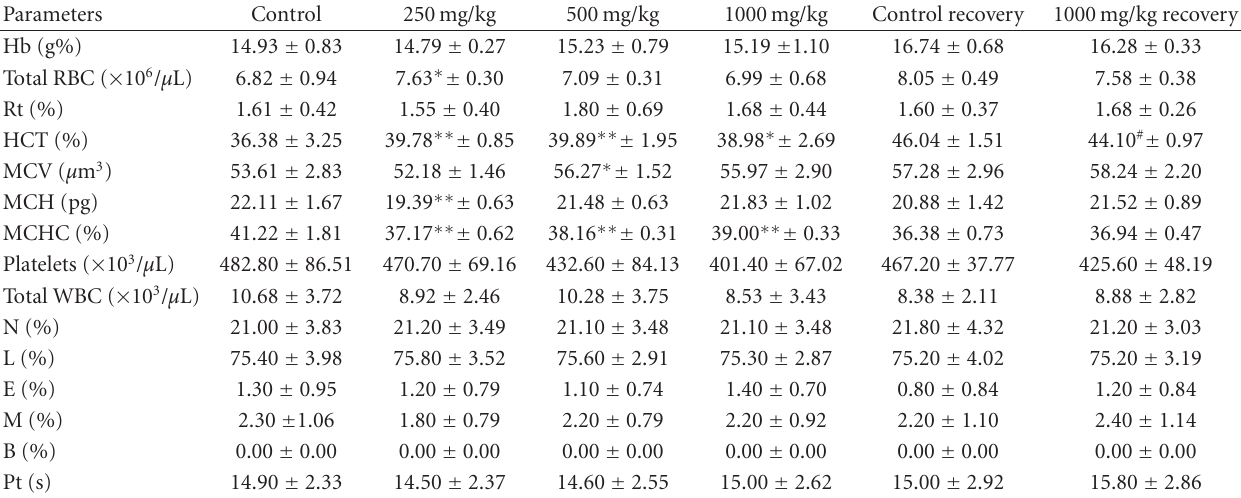
Table 3: Haematological findings (mean ± SD) in female rats after 90 days subchronic oral administration of Zigbir (cid:2) . Parameters